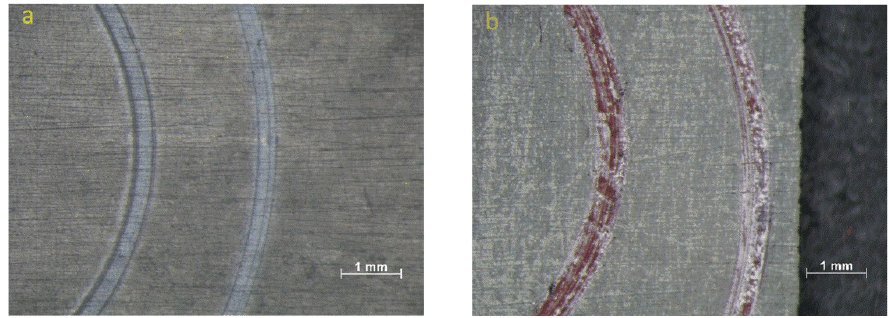
Figure 7. Microscopic images of wear tracks: ( a ) 300 nm Hybrid_B coated TPU; ( b ) 150 nm Hybrid_B coated TPU.